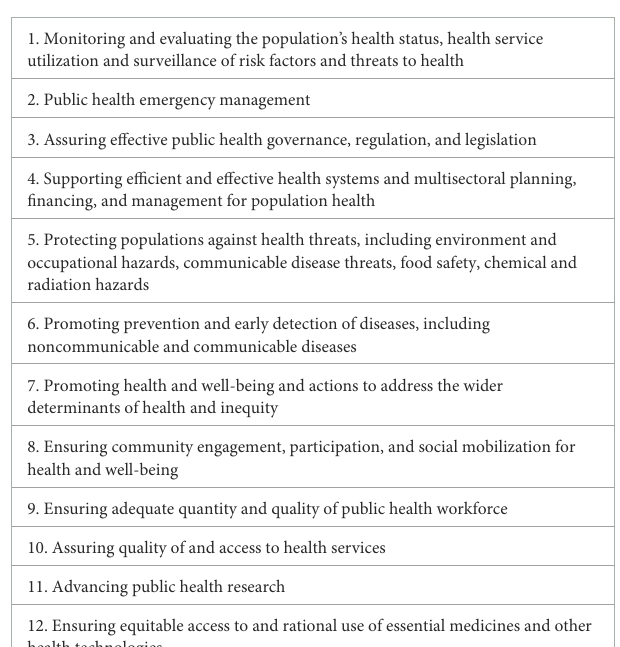
TABLE 1 Fundamental list of essential public health